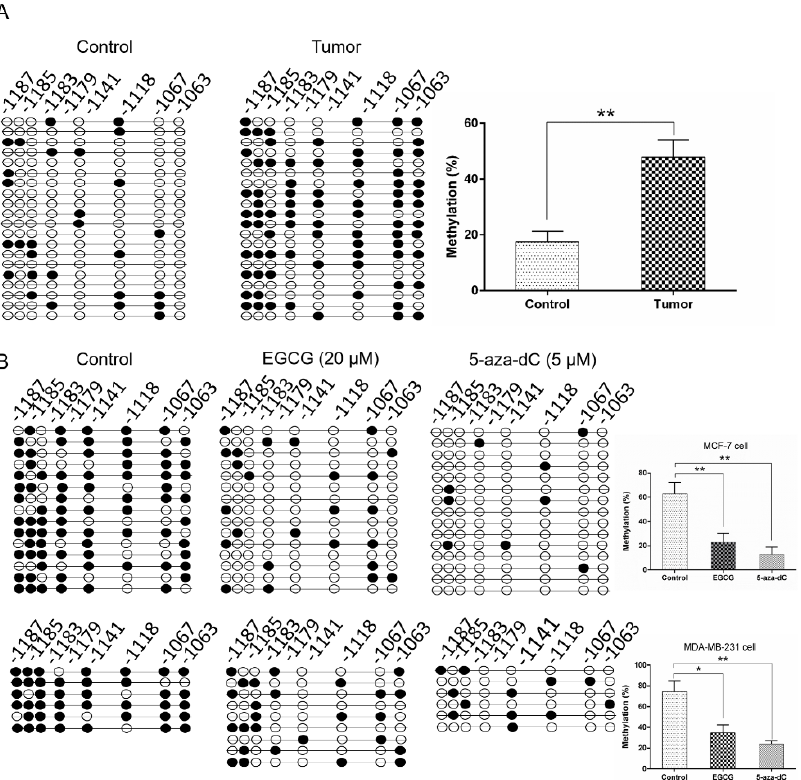
Figure 5. EGCG reduced the DNA methylation of the SCUBE2 gene. ( A ) The SCUBE2 methylation status in breast tumor tissue and adjacent control (Student’s t -test; ** p < 0.01 vs. control). ( B ) The methylation of the SCUBE2 gene in MCF-7 (upper panel) and MDA-MB-231 cells (lower panel) treated with EGCG (one-way ANOVA; * p < 0.05, ** p < 0.01 vs. control). Data are shown as mean ± SEM from three independent experiments.